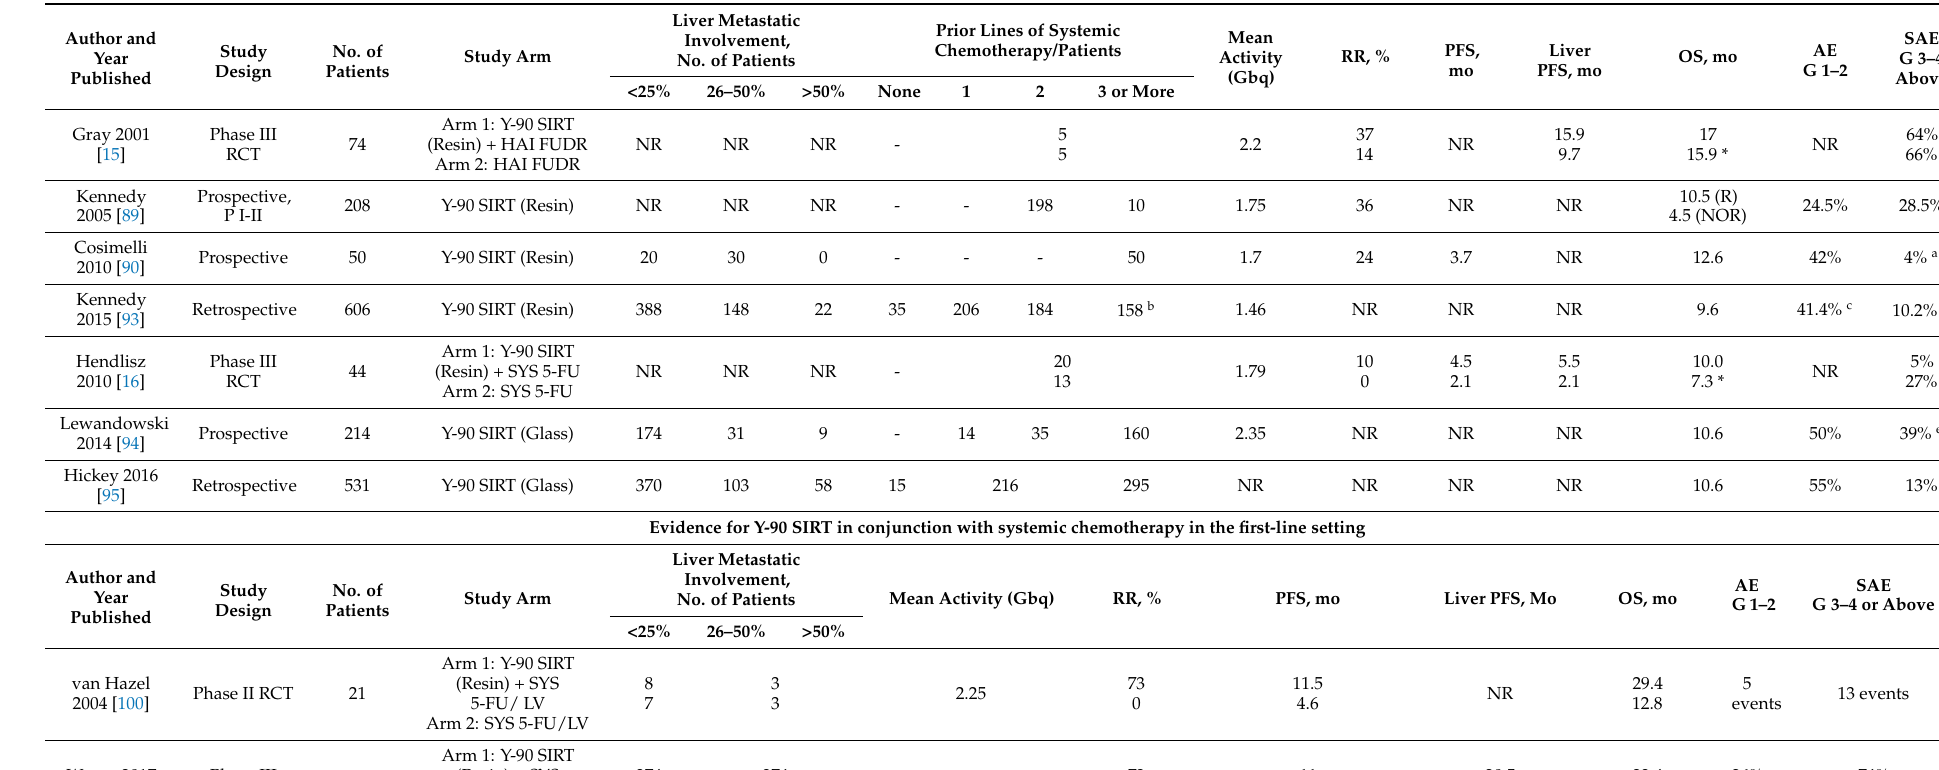
Table 3. Selected prospective trials and retrospective studies for Y-90